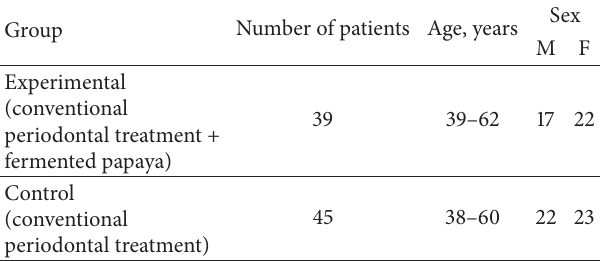
Table 1: Demographic distribution of periodontitis patients in the treatment